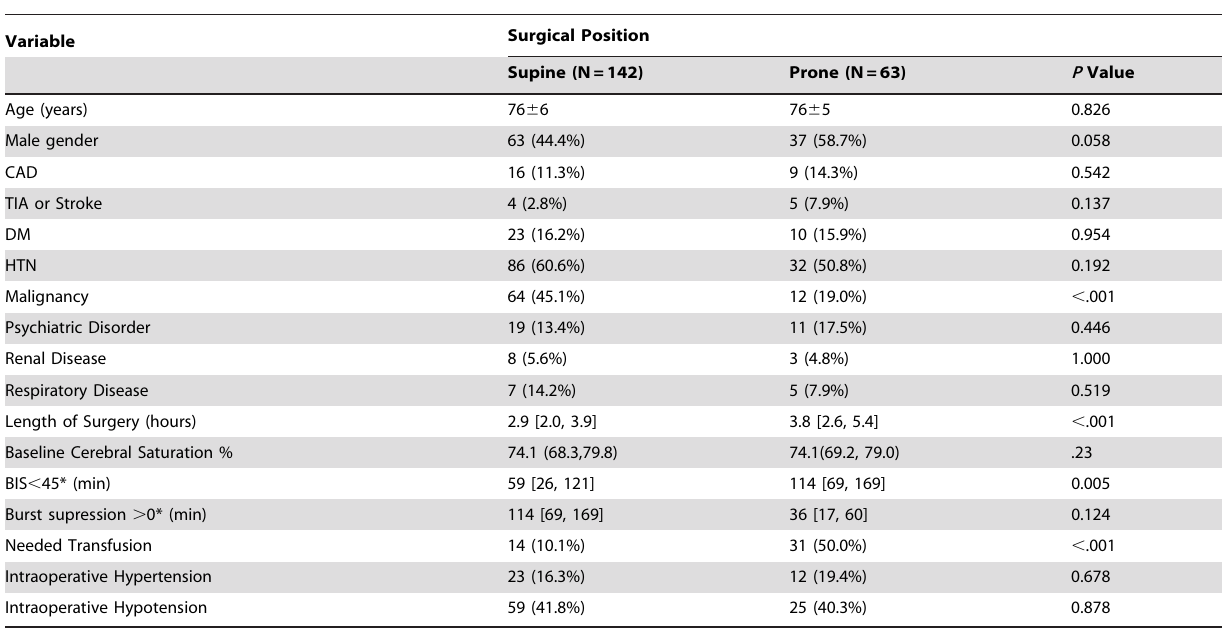
Table 2. Demographics of Supine vs. Prone Groups.